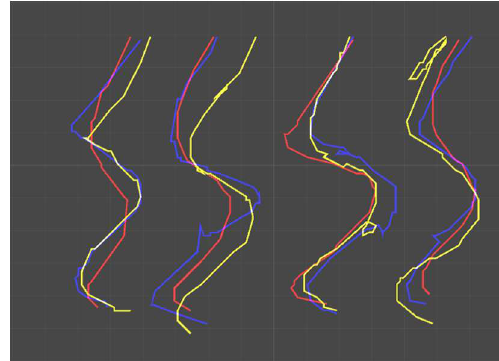
Fig. 23 No warning vs warning; order of experiment: o,r,s